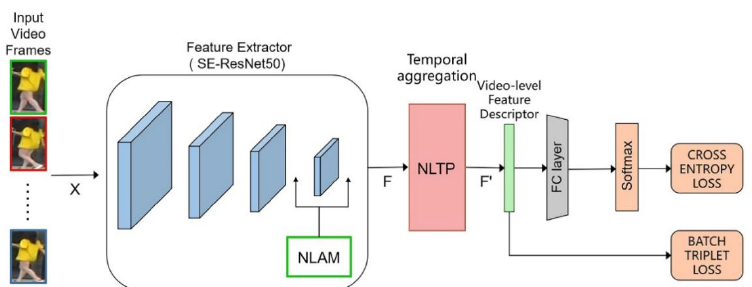
Figure 2. Our overall network architecture. X means the input video; F represents the frame-level features after passing through the feature extractor; F (cid:48) refers to the resulting video-level representation. NLAM = Non-Local Attention Module; NLTP = Non-Local Temporal Pooling; FC = Fully Connected layer.